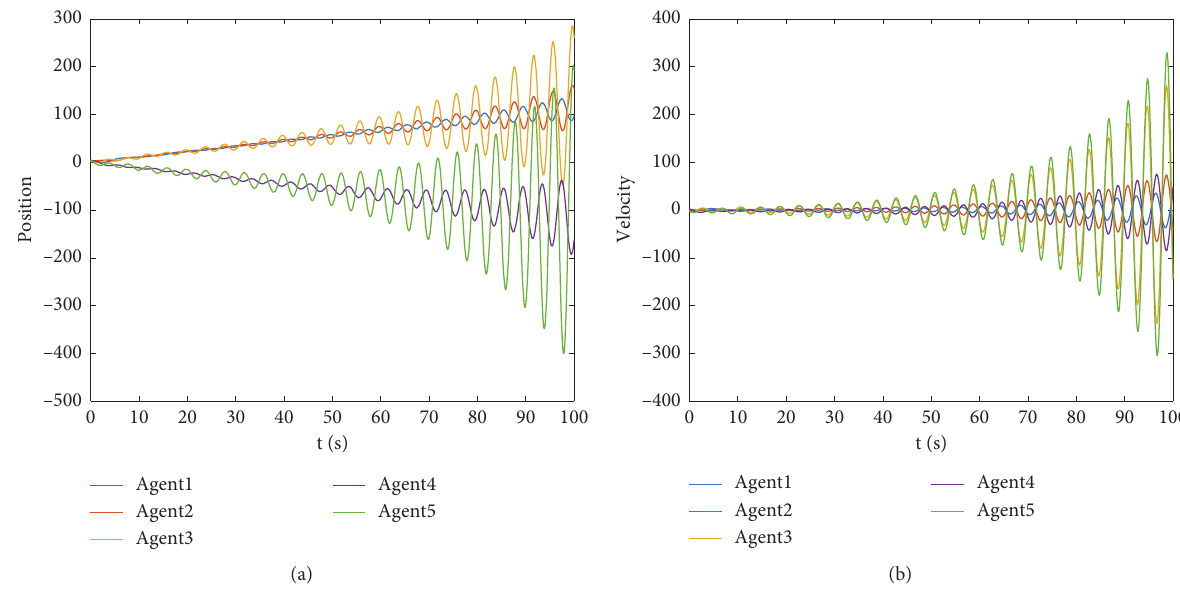
Figure 3: τ � 0 . 4 , τ � 0 . 3 , τ � 0 . 4 , τ � 0 . 3 , and τ � 0 . 6. (a) Position trajectories of all agents. (b) Velocity trajectories of all agents. 1 2 3 4 5